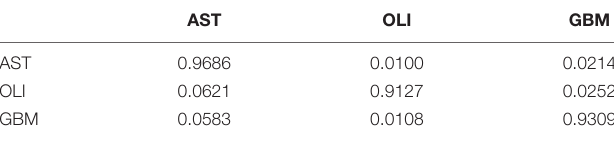
TABLE 4 | Classification performance of CDLLC on the REMBRANDT dataset. Accuracy Recall Precision F1-score Balance